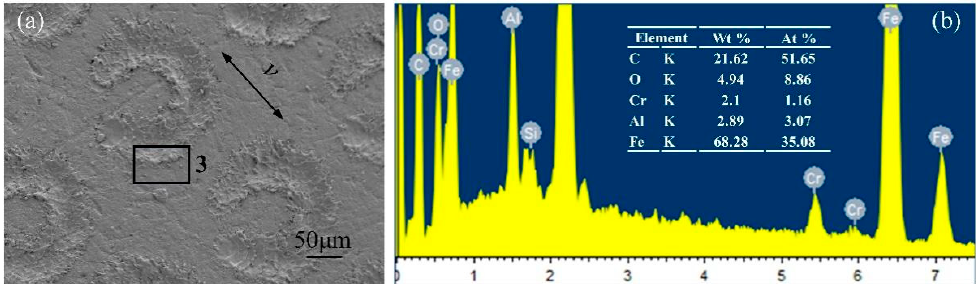
Figure 14. SEM images and EDS analysis of GCr15 metal surface under the worst coupling texture parameters: ( a ) SEM image of the sample surface with the worst coupling texture parameters; ( b ) corresponding EDS analysis.